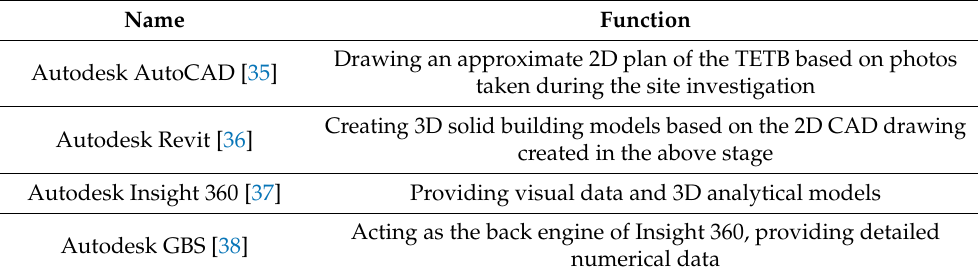
Table 3. List of selected